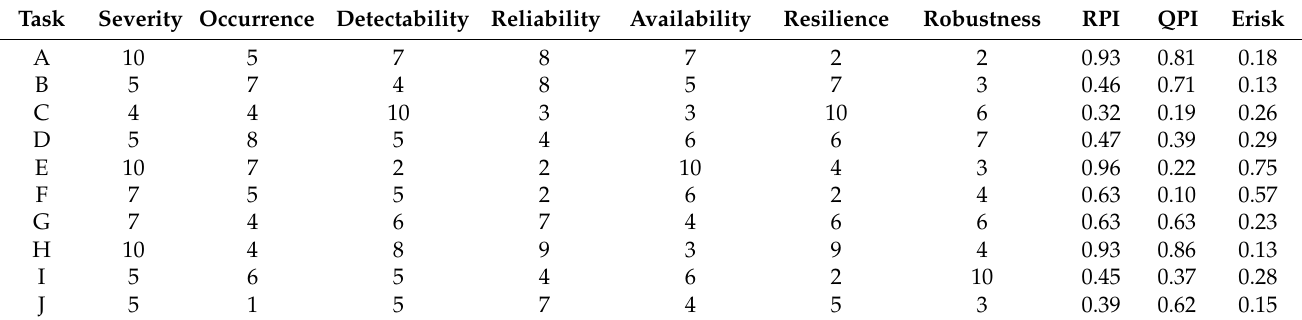
Table 8. Effective risk assessment of team 3 in each project